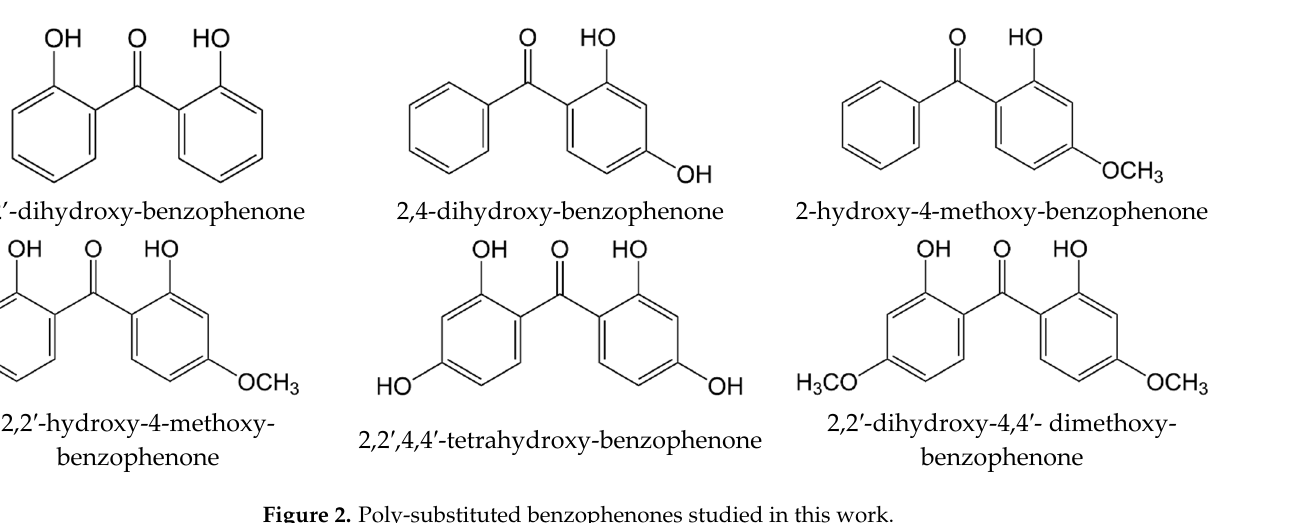
Figure 1. Mono ‐ substituted benzophenones studied in this work.